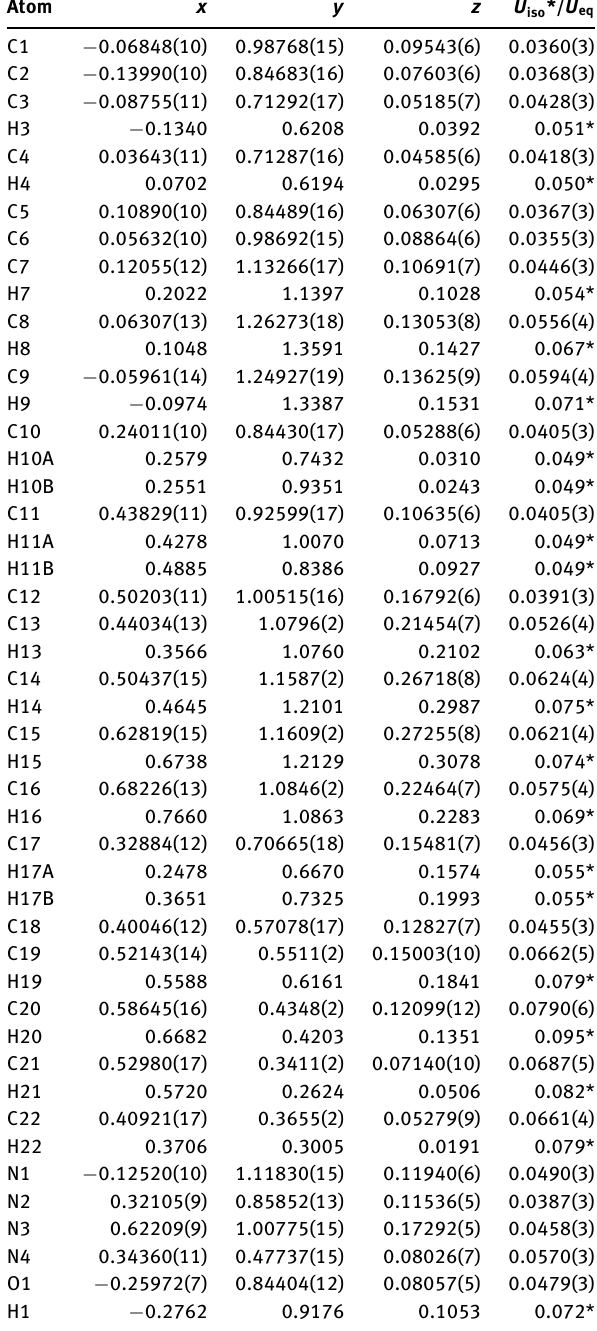
Table 2: Fractional atomic coordinates and isotropic or equivalent isotropic displacement parameters (Å 2